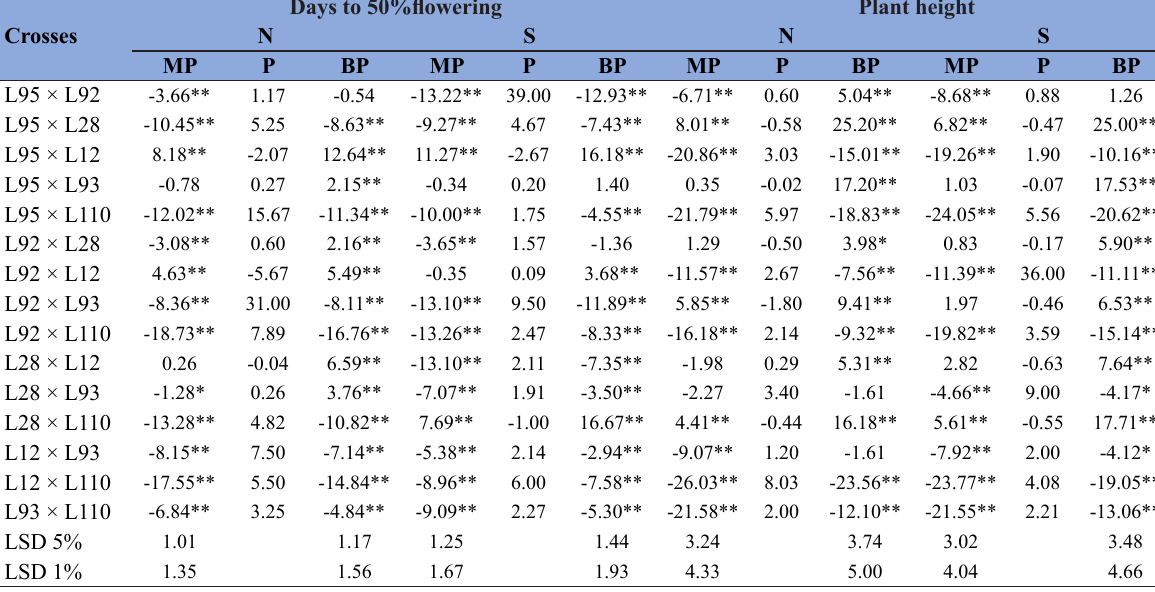
cross combinations for 1